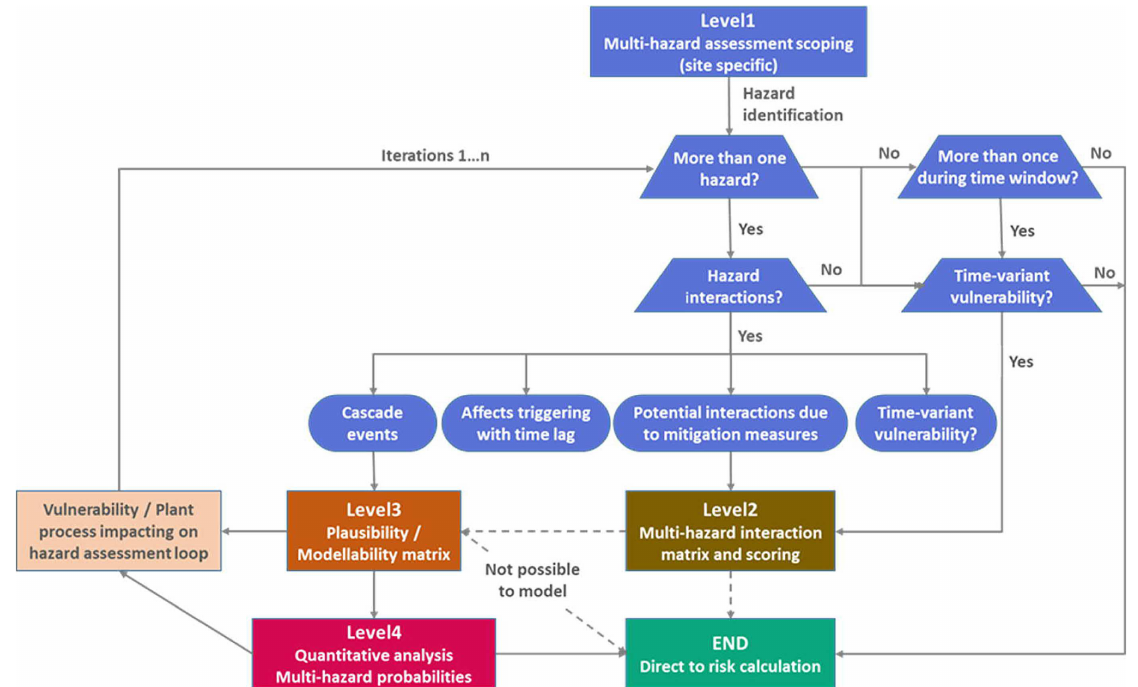
Fig. 3. The NARSIS MH framework scheme for scenarios to be used into multi-hazard